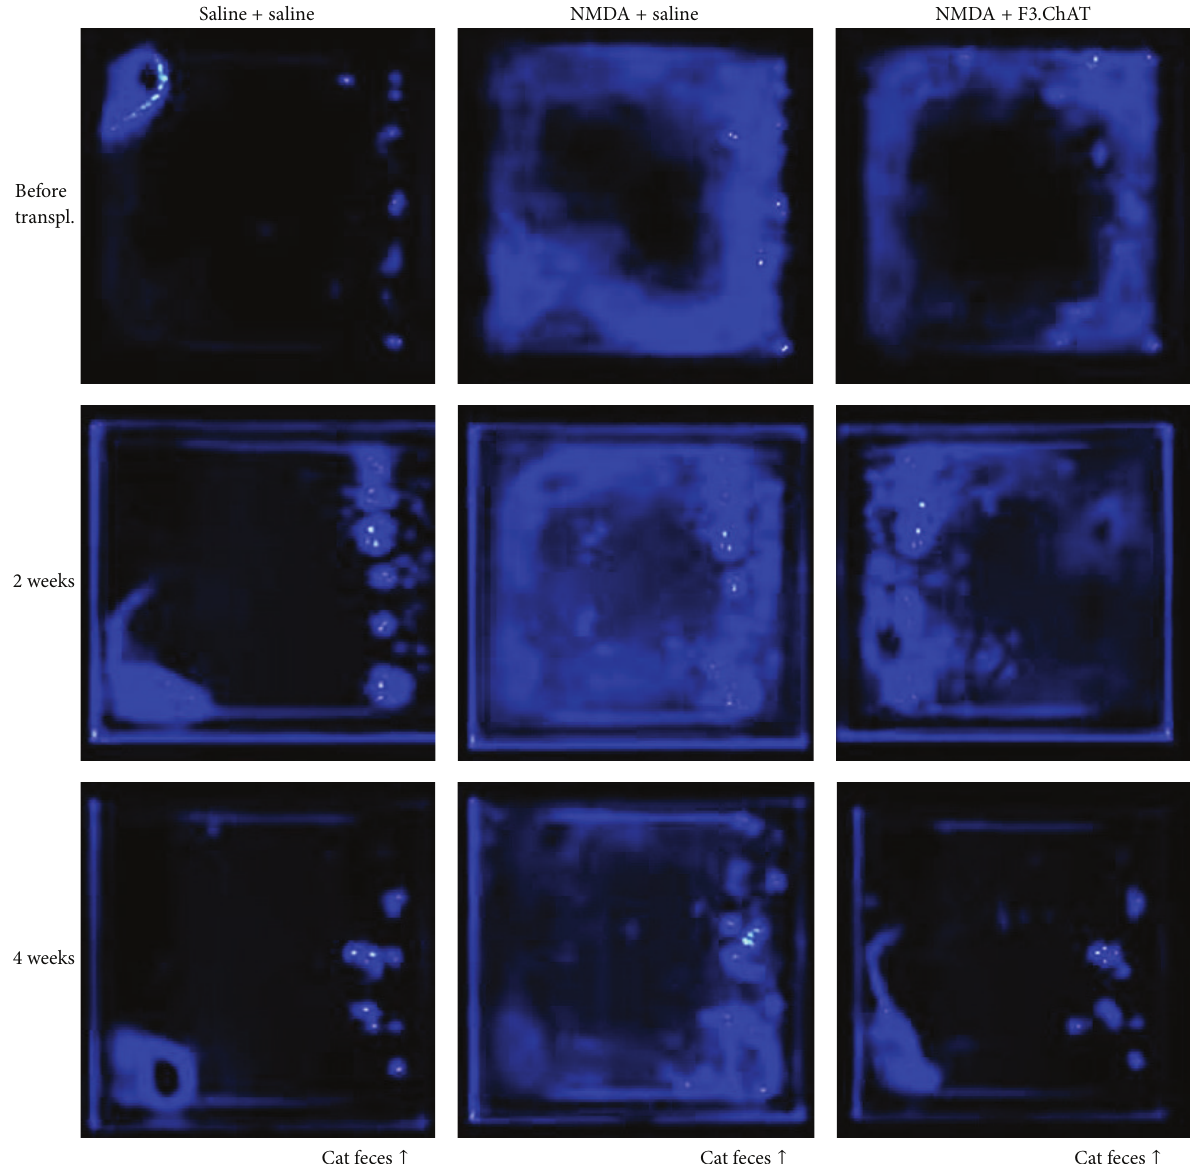
Figure 2: Densitometry on the movement of rats exposed to predator odor source along the right bottom line (cat feces, arrows). The blue prints were drawn by tracing motions of the rats. N-Methyl-d-aspartate (NMDA) was injected 2 weeks prior to F3.ChAT cell